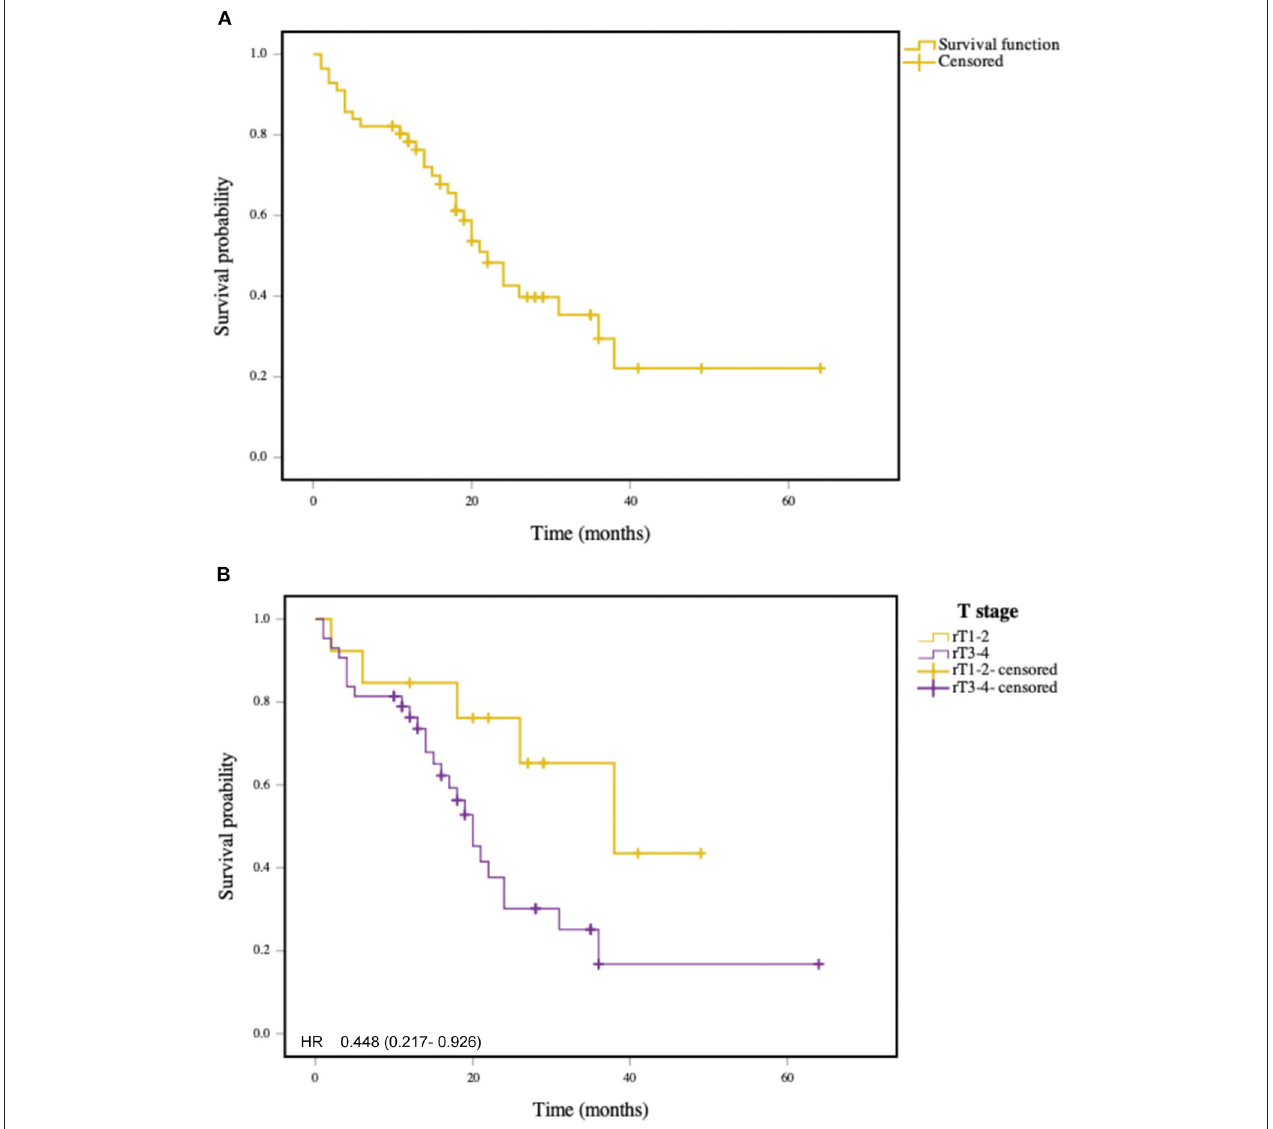
FIGURE 3 | (A) Kaplan-Meier curve of disease free survival in patients with recurrent NPC. (B) Kaplan-Meier curve of disease free survival in patients with early stage recurrent NPC and advance stage recurrent NPC ( P <